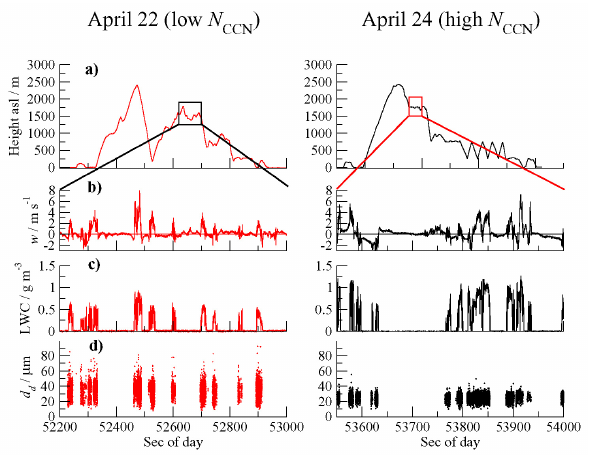
Fig. 10. Cloud observations performed on 22 April (low N CCN ) and 24 April (high N CCN ). The upper panel shows the measurement height of ACTOS in m above sea level with the boxes indicating the considered cloud regions. The following panels show the vertical velocity w , liquid water content LWC as observed by the PVM, and the lowest panel shows the droplet sizes d d as measured with the PDI for the analyzed cloud part. All x axes are in seconds of the